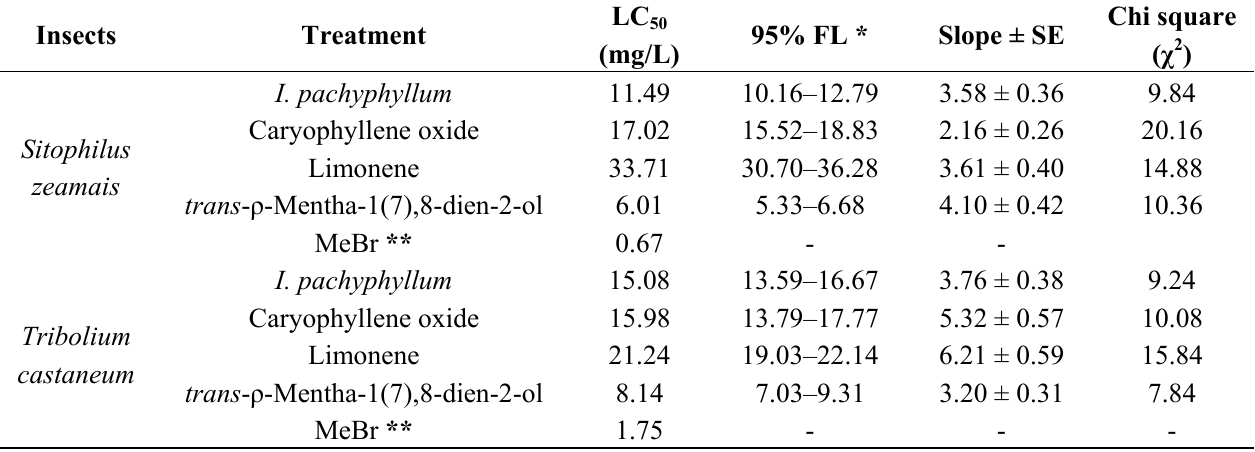
Table 3. Fumigant toxicity of the essential oil of Illicium pachyphyllum fruits and its constituents against Sitophilus zeamais and Tribolium castaneum